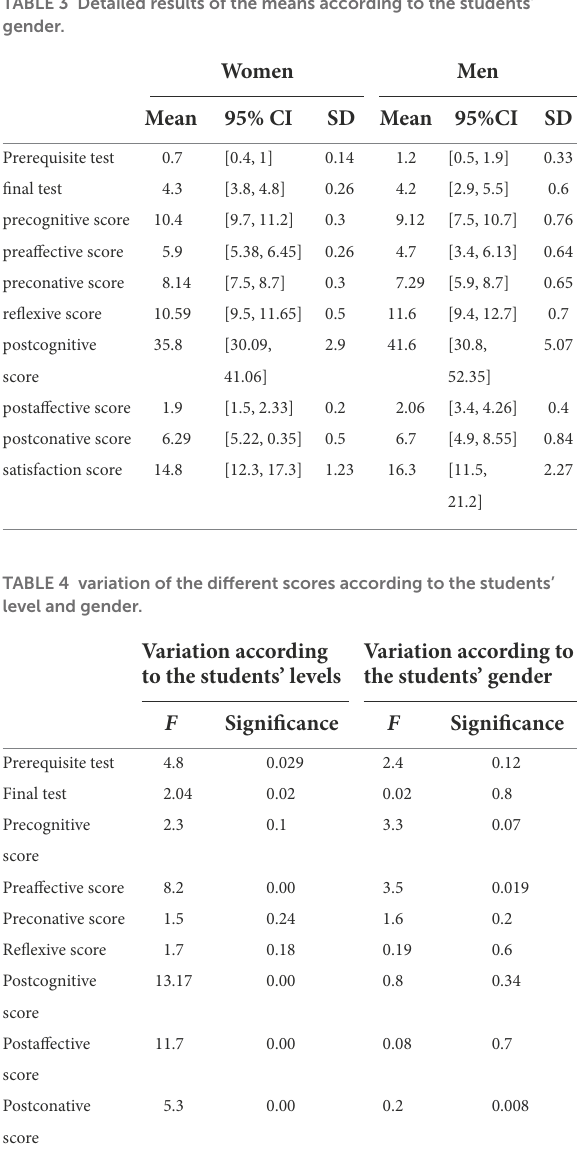
TABLE 3 Detailed results of the means according to the students’ gender.